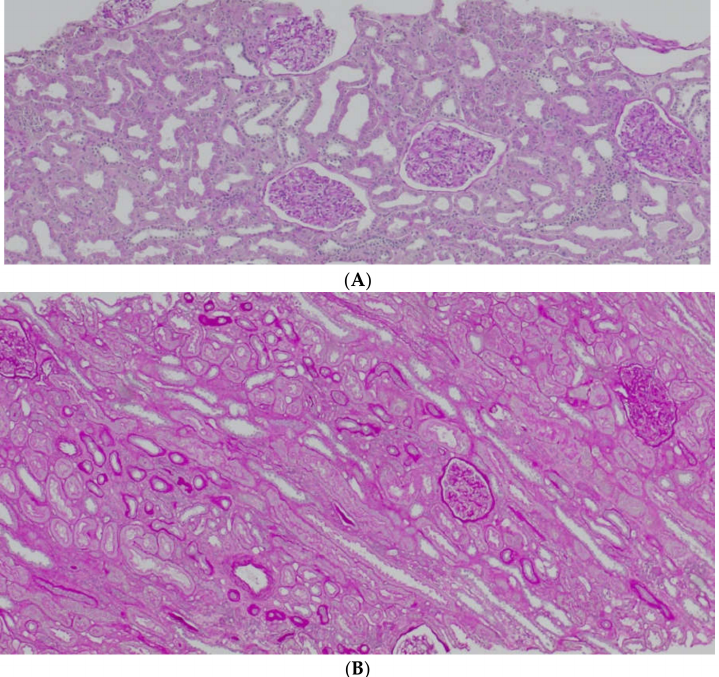
Figure 7. Histopathological images showing chronic changes graded as ci0, ct0 ( A , B ).